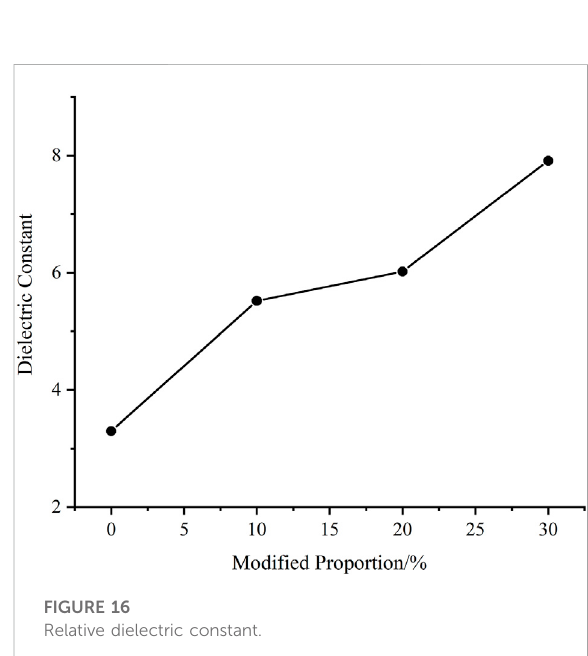
FIGURE 16 Relative dielectric